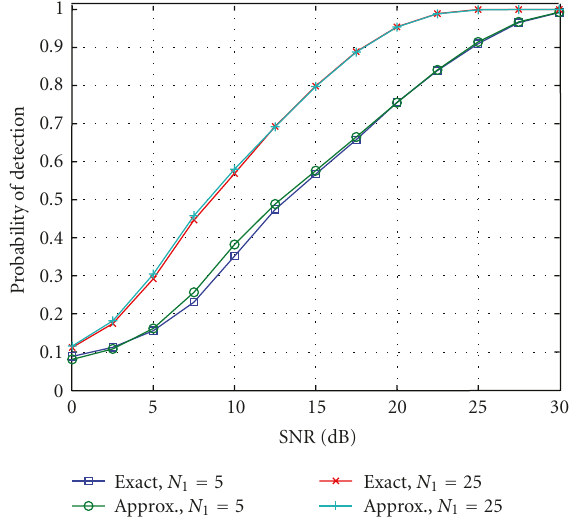
Figure 4: Probability of block detection versus SNR for N b = 20, n = 5, and ε = [3 2 . 5 2 1 . 25 0 . 5 0 15 ].